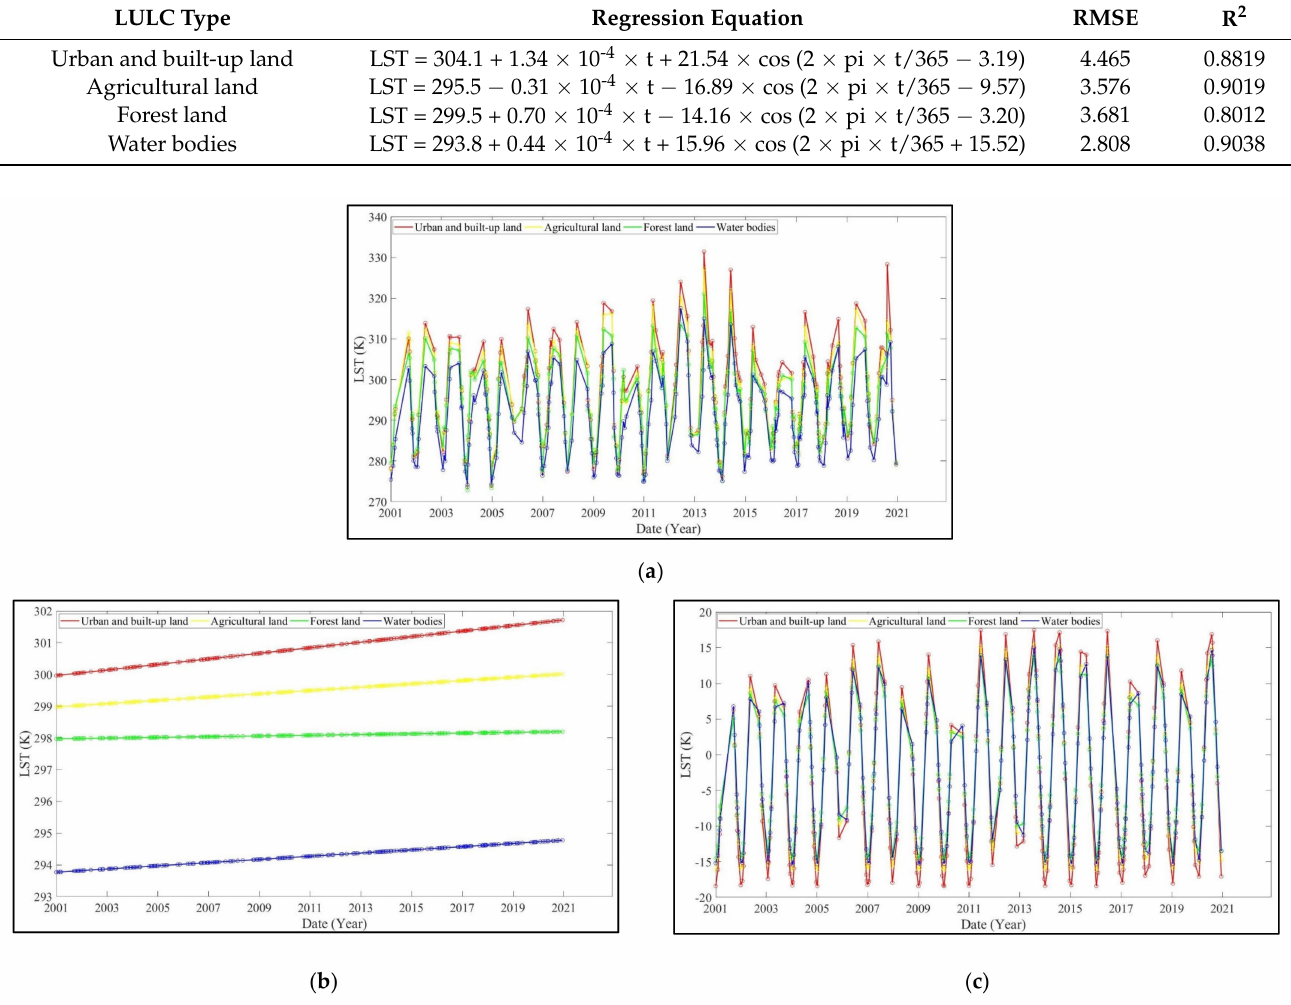
Table 6. LST regression equation for LST modeling using linear trend component and seasonality component. LULC Type